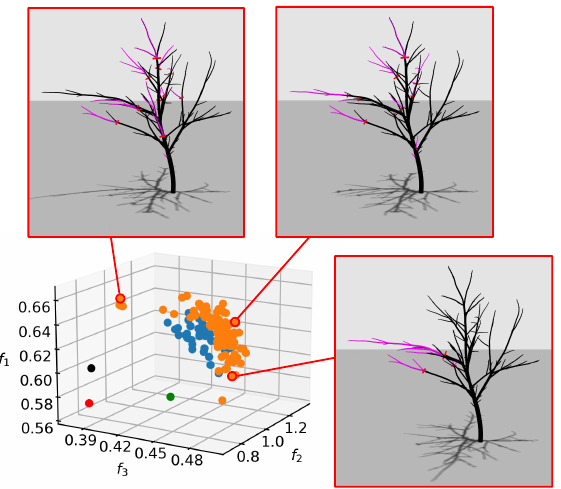
Figure 10. Pruning realizations for solutions from different regions of objective space. Distinguishing pruning patterns can be observed for solutions that promote light intake ( top left ), crown shape ( top right ), or tree balance ( bottom right